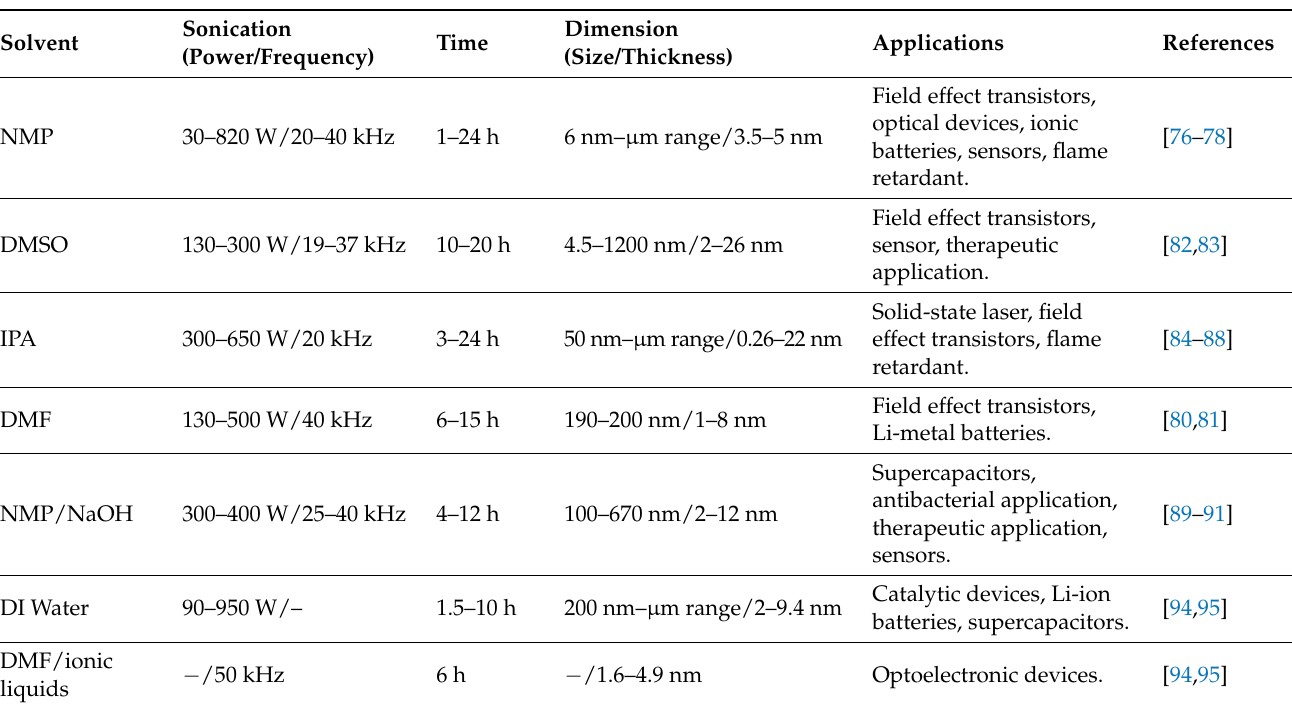
Table 1. Synthesis of BP nanosheets via liquid exfoliation and their properties as required for certain